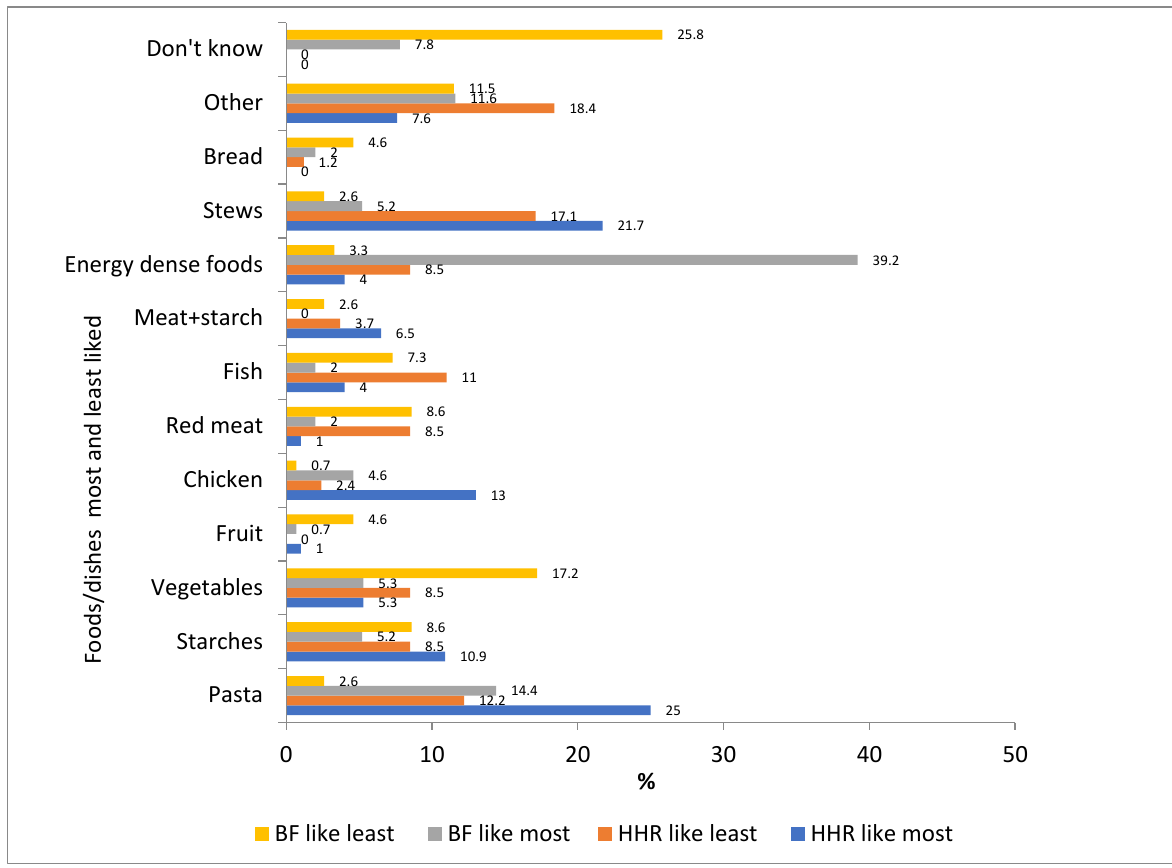
Figure 9. Foods/dishes most and least liked by household respondents (HHR n = 92) and learners’ perceptions of their best friend’s most liked and least liked foods/dishes (BF n = 153).